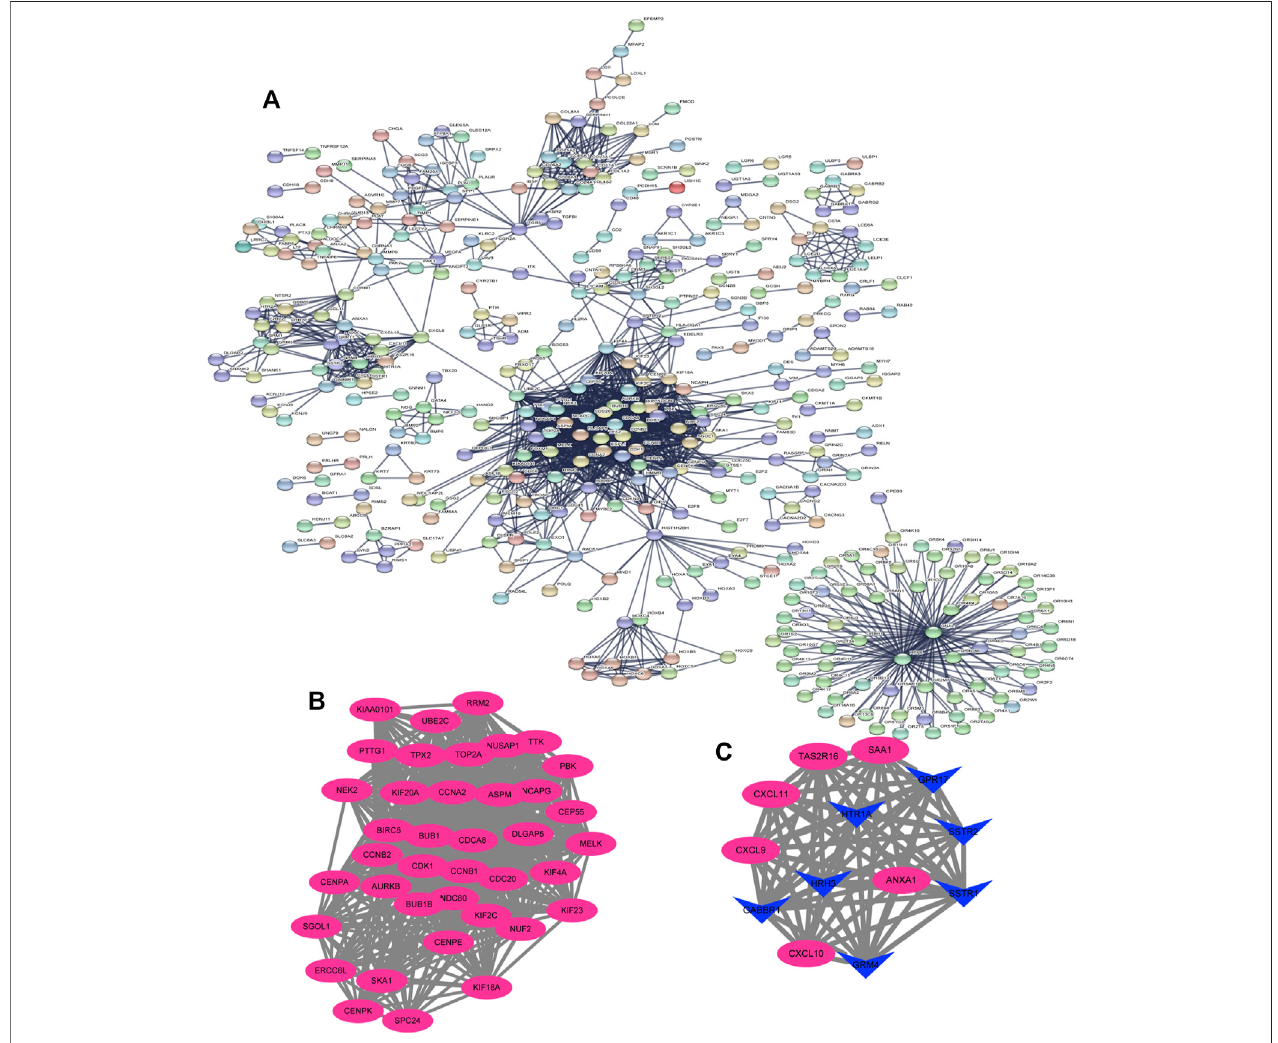
FIGURE9| Basedon theSTRING database and Cytoscapesoftware, protein – protein interaction(PPI) networks ofthedifferentially expressed genes(DEGs) were constructed, followed by modular analyses. (A) PPI networks of DEGs generated using the STRING database. (B, C) Signi fi cant gene module in the PPI networks.